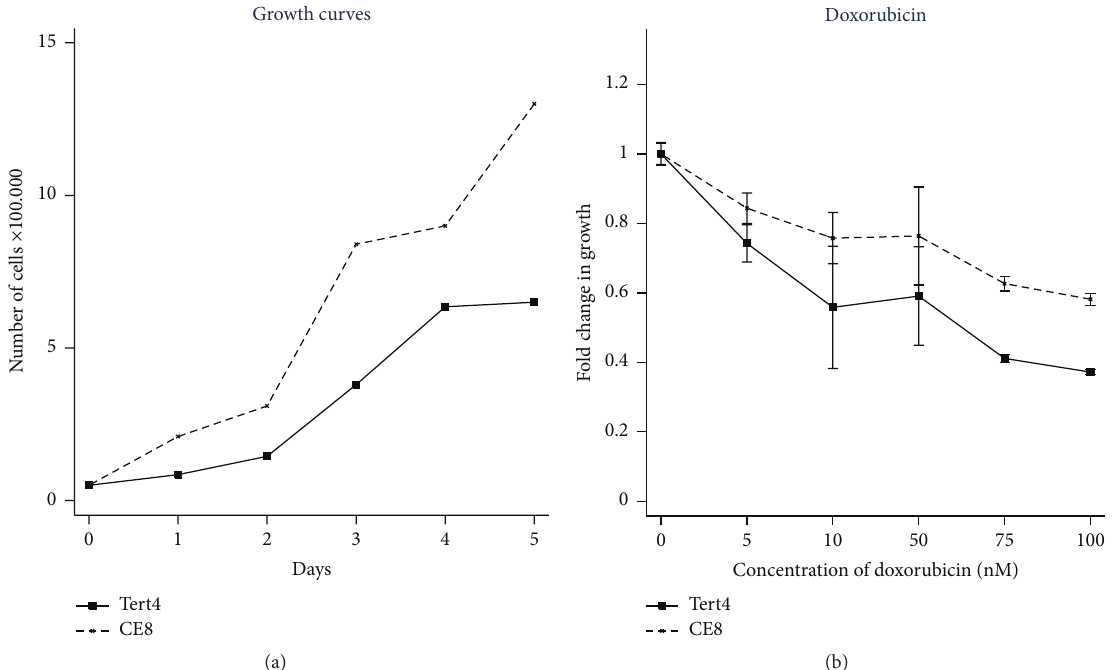
Figure 1: The growth and the sensitivity to doxorubicin of a transformed human mesenchymal (stromal) stem cell line hMSC-TERT4 (solid line) and a derived clonal cell line with the ability to form sarcoma-like tumours in mice hMSC-TERT20-CE8 (CE8, dashed line). The doxorubicin experiments were performed twice with 9 replicates (for the two highest doxorubicin concentrations the experiment was performed once and with 6 replicates). The mean fold change in growth is shown with 95% confidence interval.